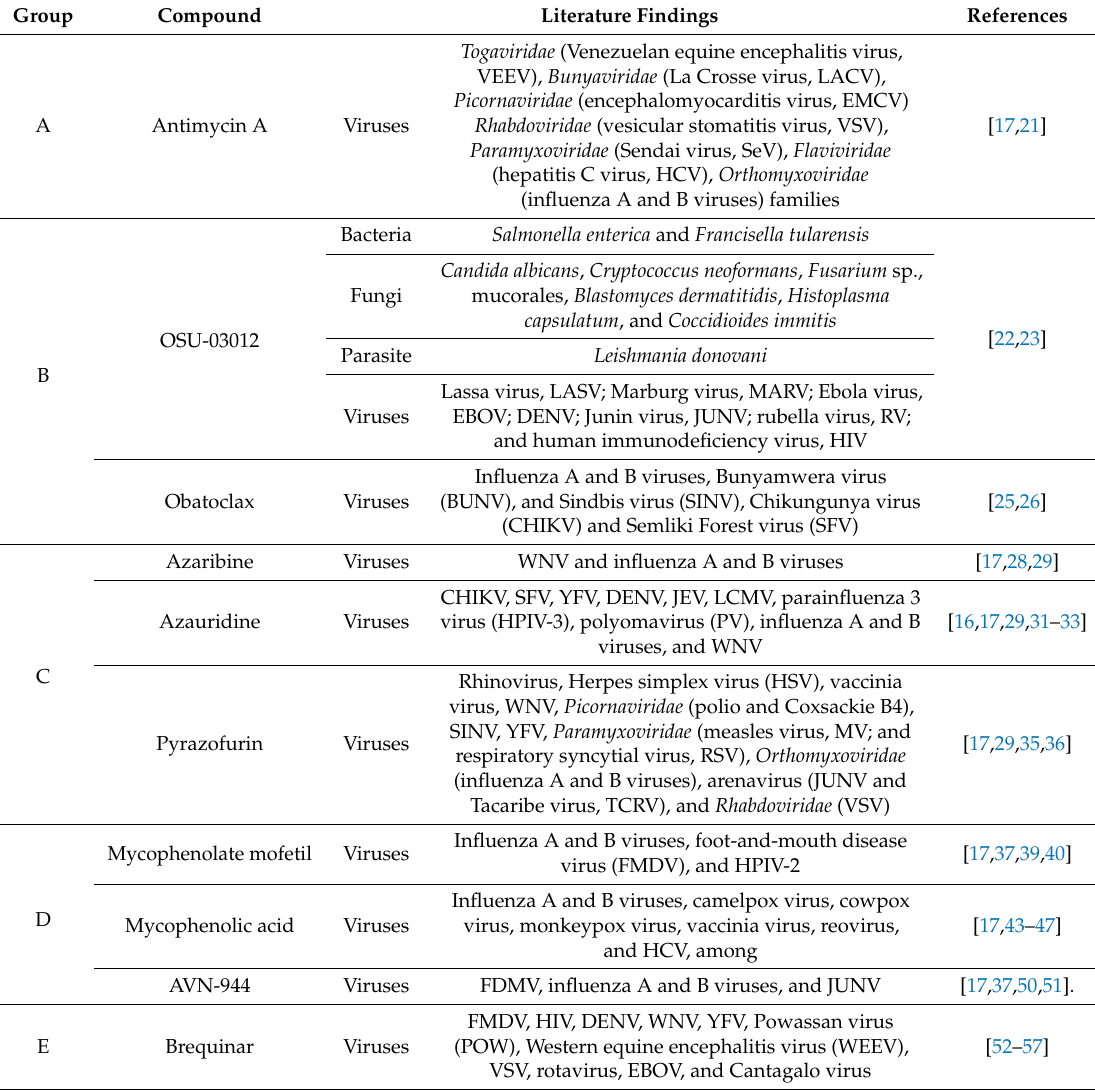
Table 7. Antiviral activity of Antimycin A, OSU-03012, Obatoclax, Azaribine, Azauridine,